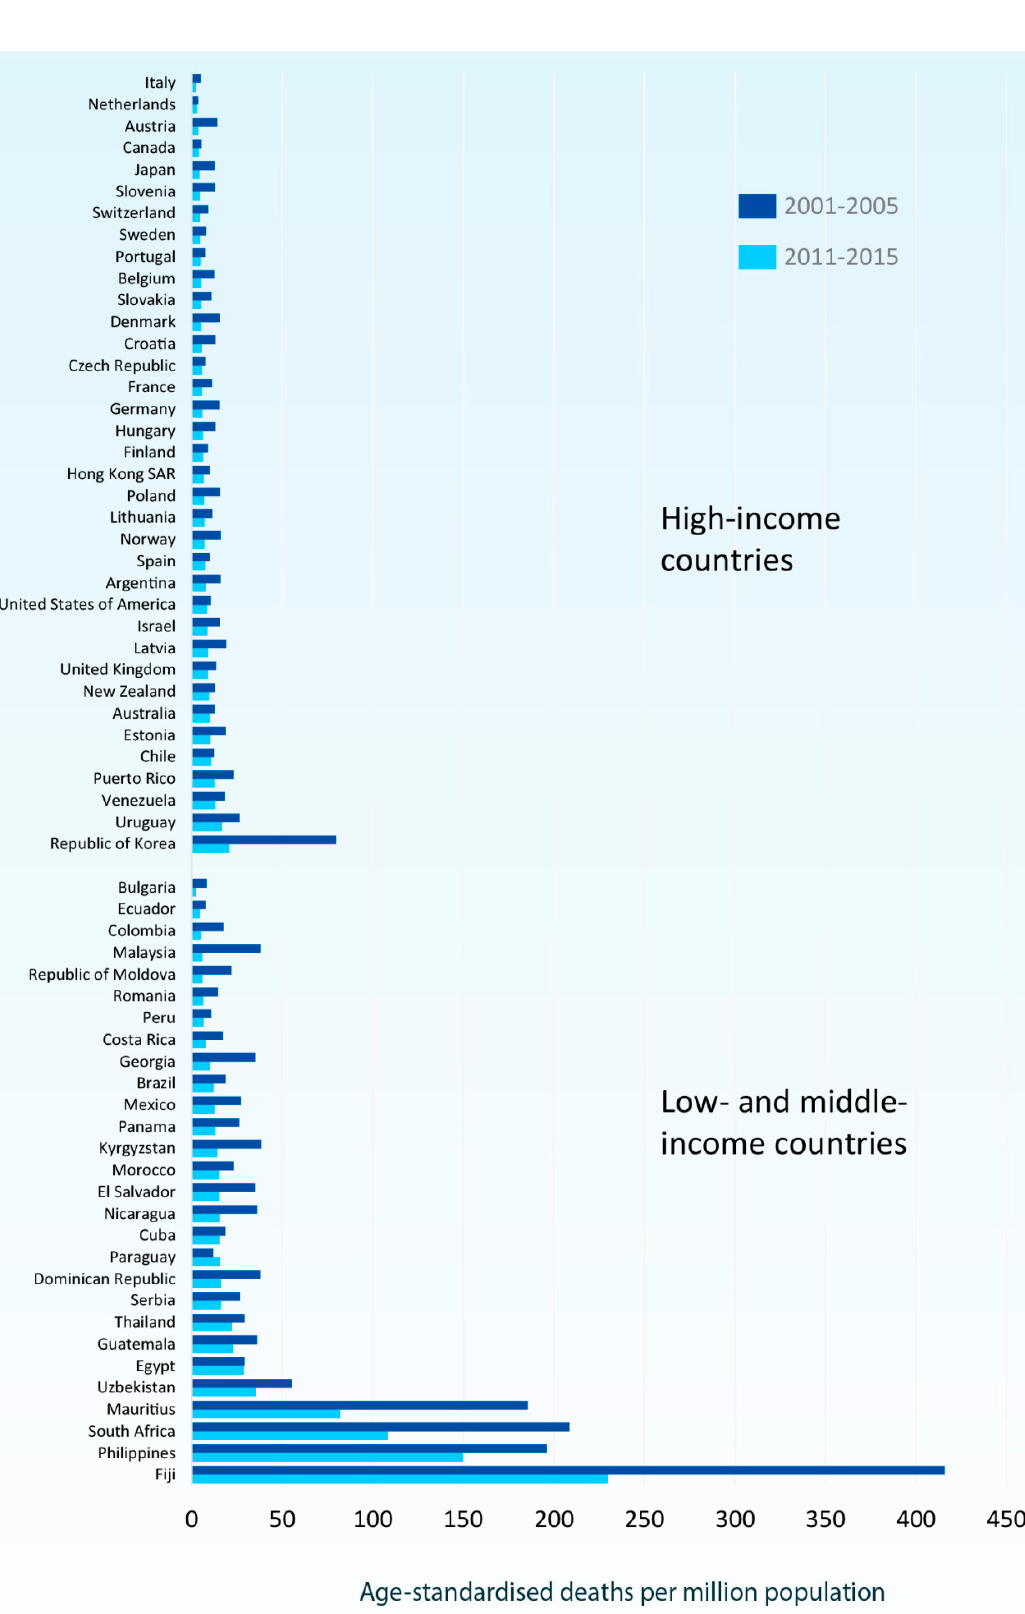
Figure 2. Age-standardized mortality rates for asthma (all ages) by country in two time periods: 2001–2005 and 2011–2015. Source: Eurostat updated from ec.europa.eu/Eurostat/web/health/health-care/data/database (version dated November 2017).